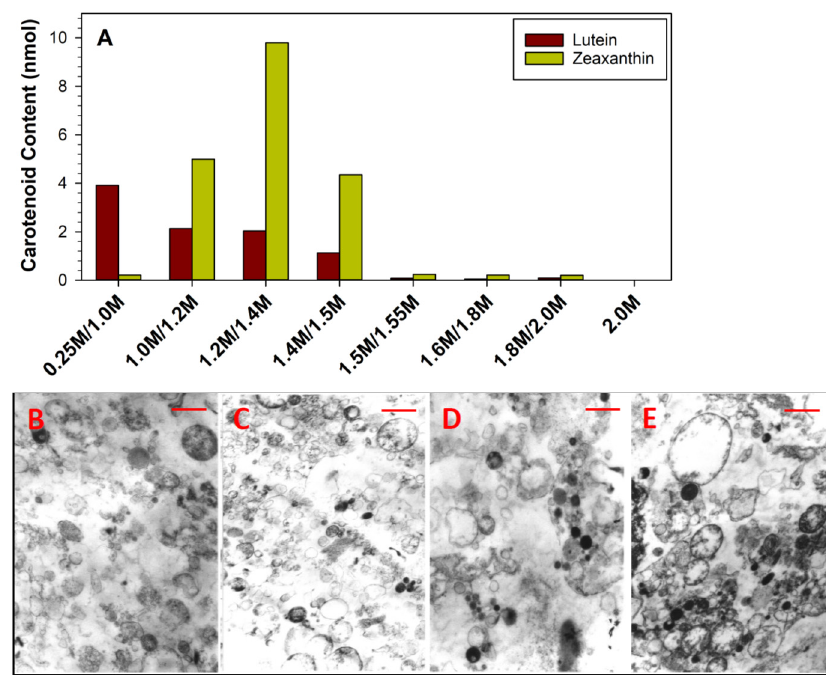
Figure 8. ( A ): Carotenoid content in subcellular fractions isolated on the discontinuous sucrose gradient at indicated interfaces of sucrose density. Representative TEM micrographs of organelles isolated from 0.25/1.00 M ( B ), 1.0/1.2 M ( C ), 1.2/1.4 M ( D ), and 1.4/1.5 M ( E ) sucrose. The length of the bar corresponds to 1 µm.